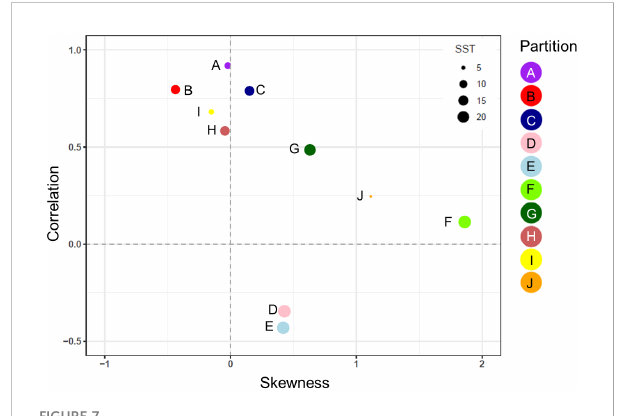
FIGURE 7 The correlation coef fi cient (r) and the skewness of the model error distribution between model and in situ data for each of the 10 zooplankton partitions. Positive skew values indicate an error distribution towards model underestimation and vice versa . Each partition cluster is represented by a different color and are scaled according to the mean sea surface temperature (SST) within each partition.